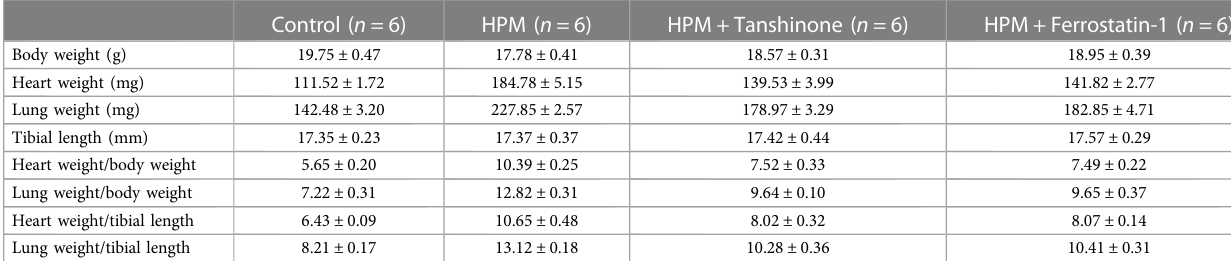
TABLE 2 Body weight, heart, lung weight tibia length parameters in HPM and treatment group